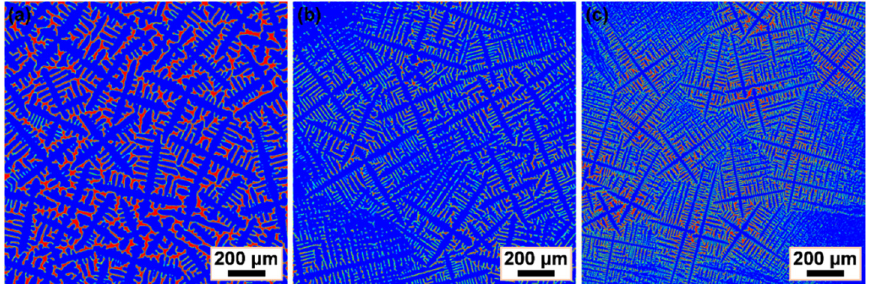
Figure 6. Simulated dendritic morphologies of AlSi10Mg alloy under different cooling rates: ( a ) 10 K/s; ( b ) 100 K/s; ( c ) 1000 K/s.